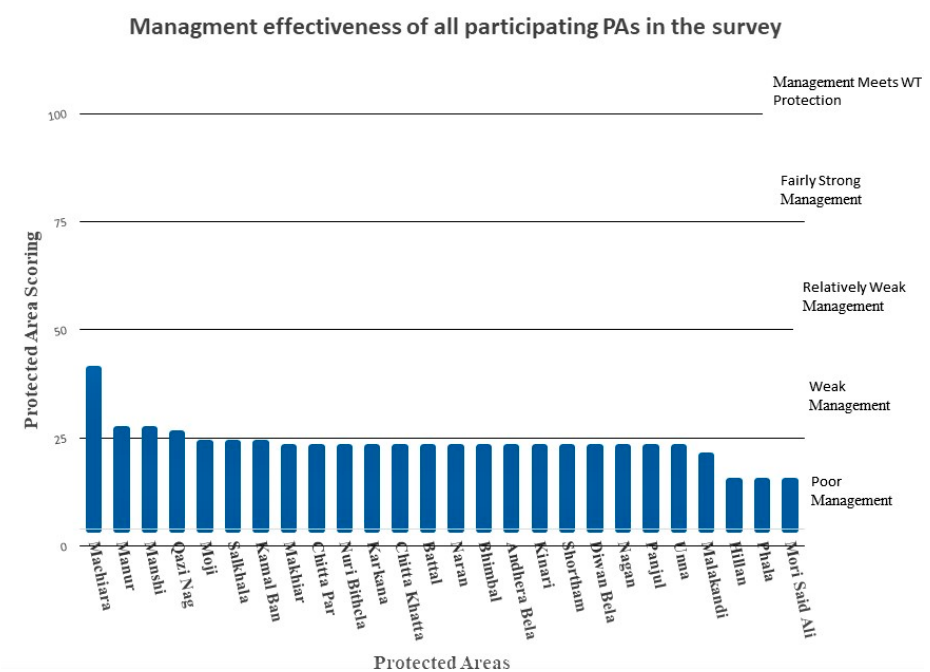
Figure 2. Management effectiveness of different protected areas surveyed during the